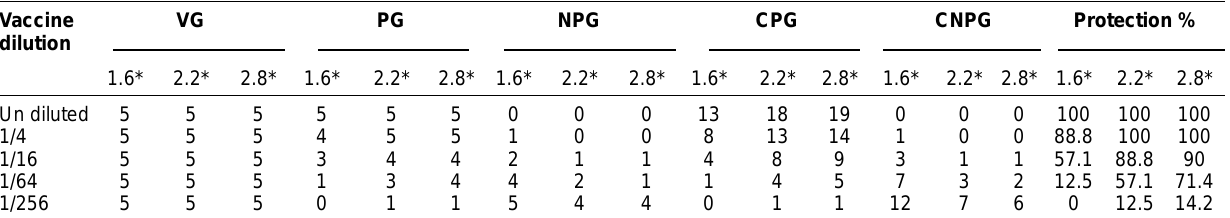
VG: No. of vaccinated guinea pigs, PG: No. of protected guinea pigs, NPG: No. of non protected guinea pigs, CPG: Cumulative no. of protected guinea pigs, CNPG: Cumulative no. of non protected guinea pigs, (* 146S µg/ml), GPPD (1.6µg 146S of O) = 40.6, GPPD (2.2 µg 146S of O) = Table-3 GPPD of FMD virus type A Iran O5 with different 146S content vaccine. 50 Vaccine VG